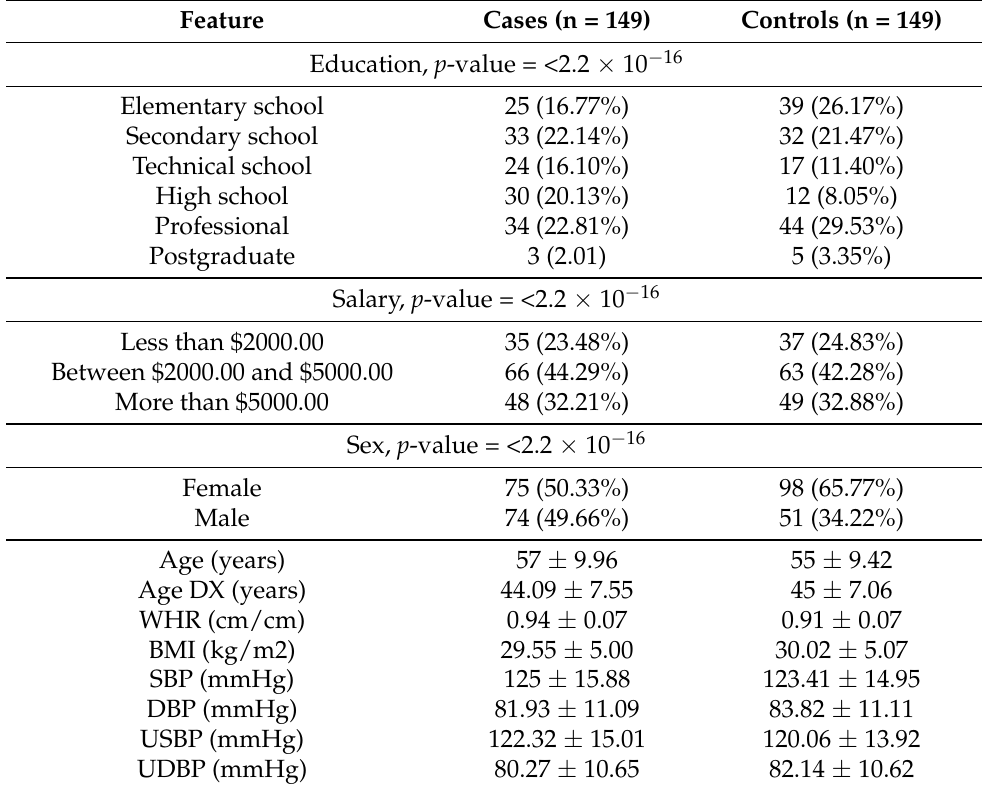
Table 2. General characteristics of all the subjects included.